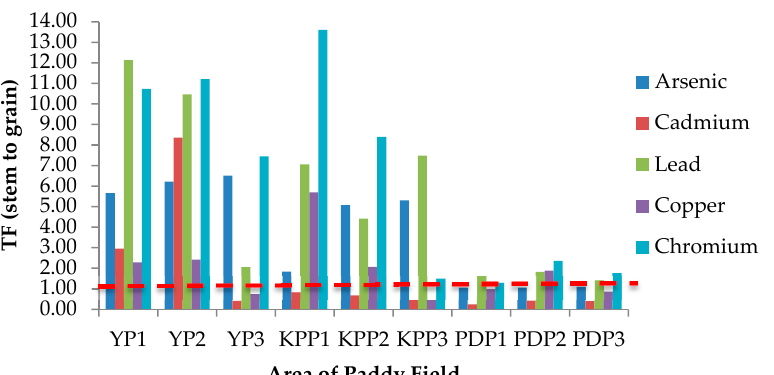
Figure 5. Translocation factor (TF) of studied metals from stem to grain (TF stem ) in areas of Yan, Kubang Pasu, and Pendang. YP1: Yan Plot 1, YP2: Yan Plot 2, YP3: Yan Plot 3, KPP1: Kubang Pasu Plot 1, KPP2: Kubang Pasu Plot 2, KPP3: Kubang Pasu Plot 3, PDP1: Pendang Plot 1, PDP2: Pendang Plot 2, and PDP3: Pendang Plot 3.